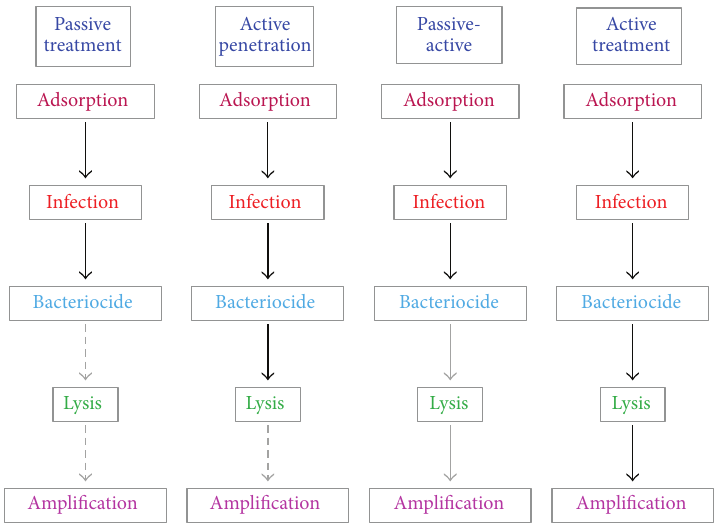
Figure 11: Comparing proximate outcomes during different categories of phage therapy progress. In passive treatment, only cell killing must occur as a proximate outcome, though cell lysis as well as in situ amplification of phage numbers may occur as well. By definition, though, they do not have to happen for passive treatment to successfully clear a bacterial infection (hence use of dashed, grayed arrows towards the bottom of this column). Phage active penetration into bacterial biofilms appears to be dependent on some form of phage enzymatic activity other than those required to physiologically or genetically kill bacteria. Here this is indicated as bactericidal infection occurring in combination with bacterial lysis, with the latter contributing to further phage penetration into biofilms and/or improved phage-infection physiology. Such phage activity potentially may also improve antibiotic [223] or disinfectant [224] penetration into biofilms or at least their effectiveness against biofilms. Phage in situ amplification, though potentially helpful towards further phage penetration, nonetheless in this case is not necessarily absolutely required (dashed, gray arrow). Payne and Jansen [52] describe an intermediate state between active and passive treatment that they term “mixed passive/active” (here, for clarity, “passive-active”). This treatment approach involves a combination of dosing with large numbers of phages and subsequent phage population growth. It is the opinion of this author that this latter approach, possibly in combination with multiple dosing, likely either should or does represent a default approach to effecting phage therapy treatments. This represents supplying relatively large phage numbers to bacterial infections—in single or multiple doses—though nonetheless supplying phage numbers that are less than completely overwhelming (i.e., less than completely inundative) with the assumption that phage in situ population growth will enhance those numbers local to either planktonic bacteria or instead bacterial biofilms or microcolonies. See Abedon [225, 226] for consideration of the latter. The reduced but not eliminated requirement for lysis and amplification in the case of “passive-active” is indicated using solid but gray arrows rather than dashed gray arrows. Lastly, active treatment by definition is dependent on both lysis and in situ phage amplification (black, solid